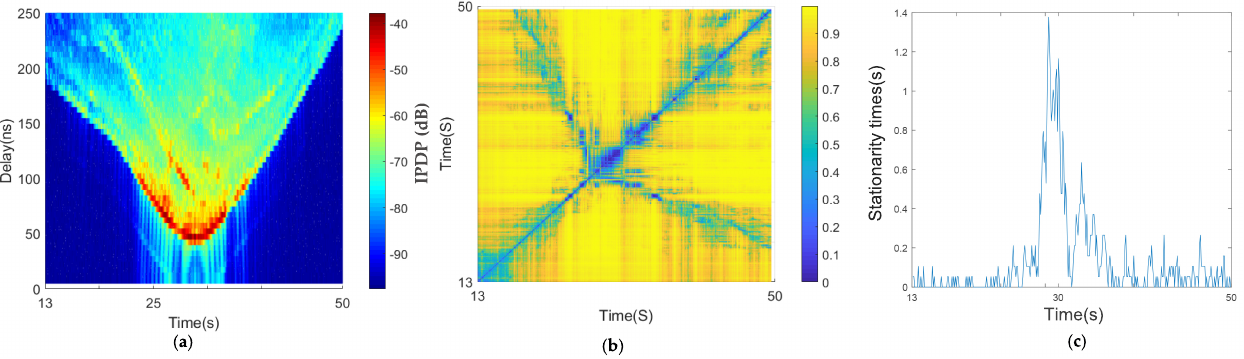
Figure 11. Results of the urban intersection scenario: ( a ) average PDPs, ( b ) temporal PDP correlation coefficient, and ( c ) stationarity time